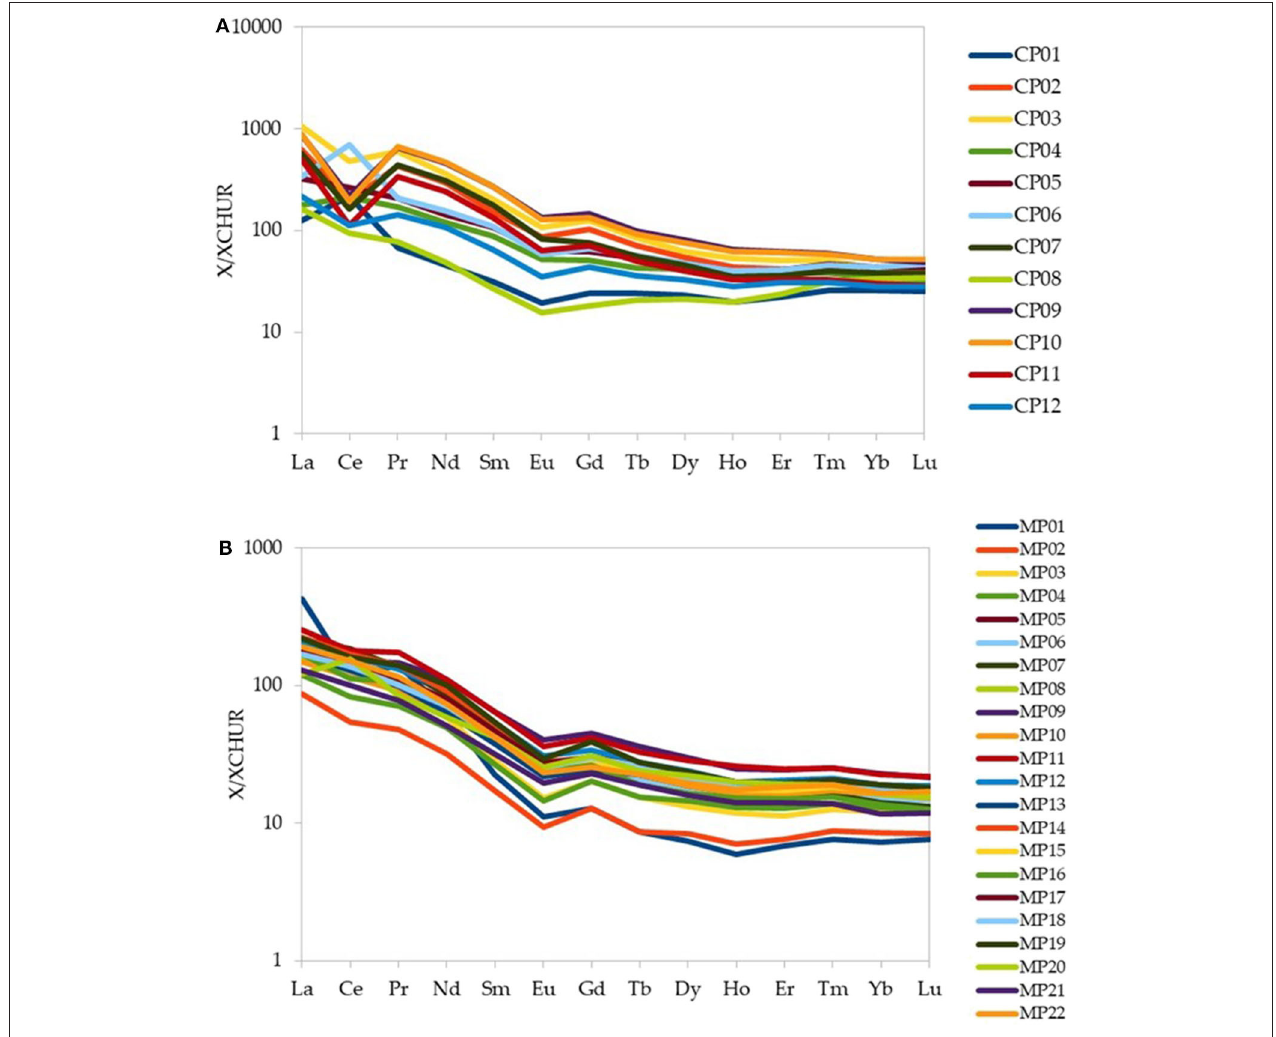
FIGURE 10 | Chondrite-normalized REE patterns of (A) the CP palaeosols, and (B) the MP palaeosols. Chondrite values are from Taylor and McLennan